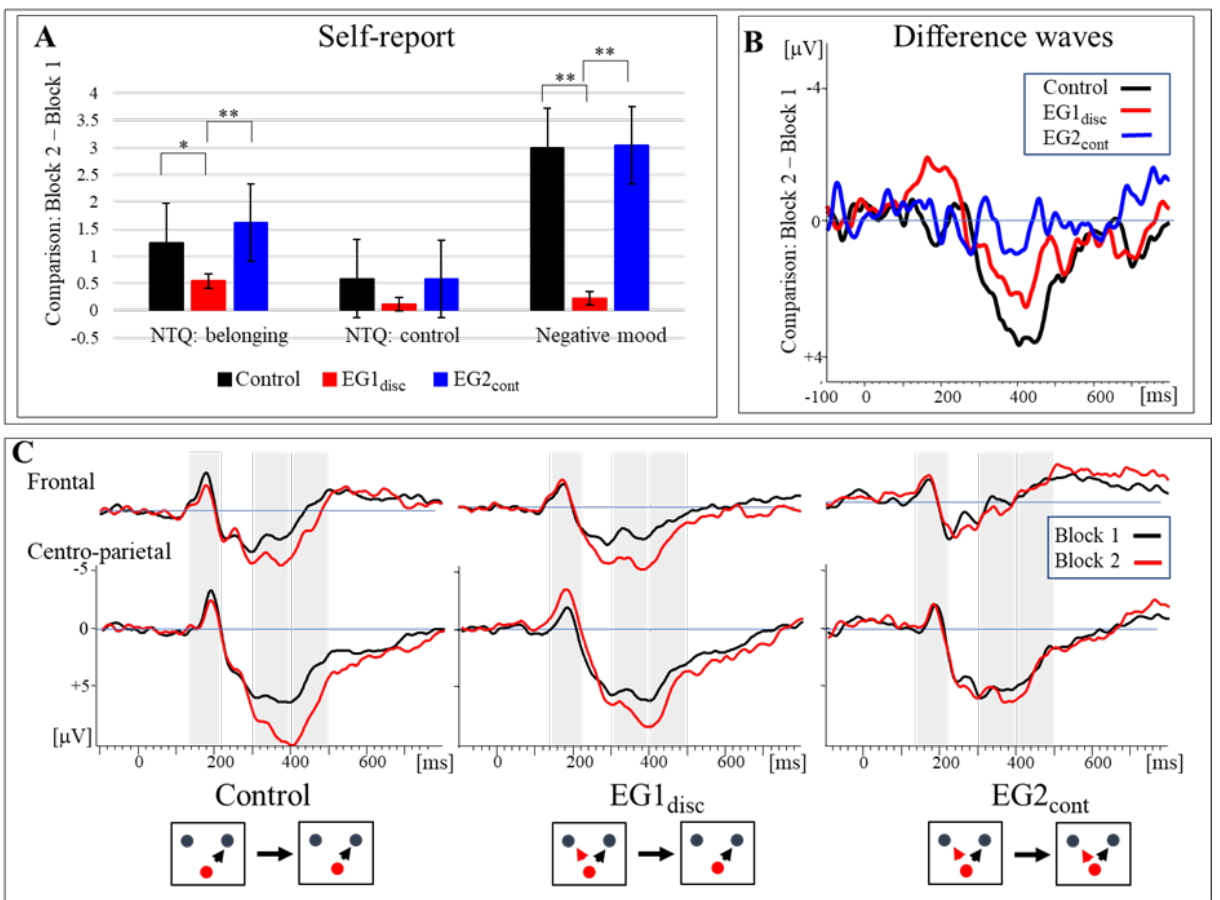
Figure 2. ( A ) Self-report data. The retrospective rating of need threats (NTQ belonging, NTQ control) and negative mood is based on the relative judgement (block 2 – block 1). ( B ) Difference ERP waves (block 2 – block 1) computed for the centro-parietal electrode cluster: The P3 effect induced by the transition to exclusion is clearly expressed in the controls and EG1 disc , but not in EG2 cont . ( C ) Grand-averaged ERP waveforms (block 1 and block 2) separated for the three groups and two experimental blocks. Time regions which are analyzed are shaded: N2 (140 – 220 ms) and P3 (300 – 400 ms and 400 – 500 ms). The P3 effect — induced by the transition to exclusion — is mostly expressed in controls and EG1 disc at the central parietal cluster. The N2 amplitude was selectively increased at posterior electrodes in EG1 disc . Here, the icons refer to the experimental condition (see Fig. 1b): The red dot refers to the avatar of the participant. A red arrow indicates that interventions are possible in the experimental block. Control: the control group; EG1 disc : the first experimental group (the preexposure provided but discontinued); EG2 cont : the second experimental group (the preexposure provided and continued). * p < 0.05; ** p < 0.01.